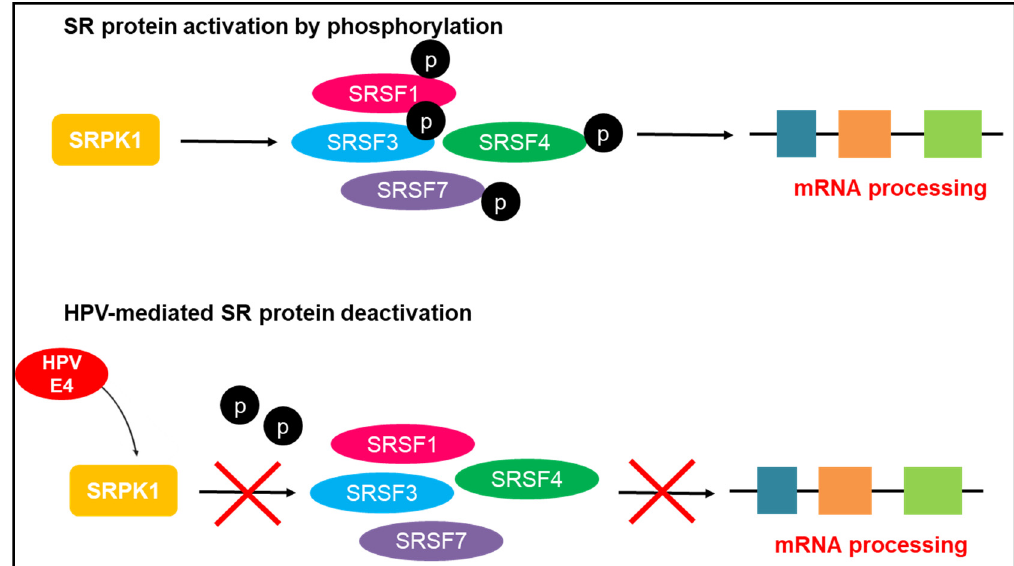
Figure 4. Human papillomavirus (HPV)-mediated disruption of accurate mRNA processing. The binding of HPV E4 protein leads to the deactivation of SR splicing factors (SRSFs) 1, 3, 4, and 7 by the loss of phosphorylation. This concomitantly inhibits pre-mRNA splicing, leading to inaccurate splicing and production of oncoproteins that give rise to malignancy [18,67]. SRPK: SR protein-specific kinase.